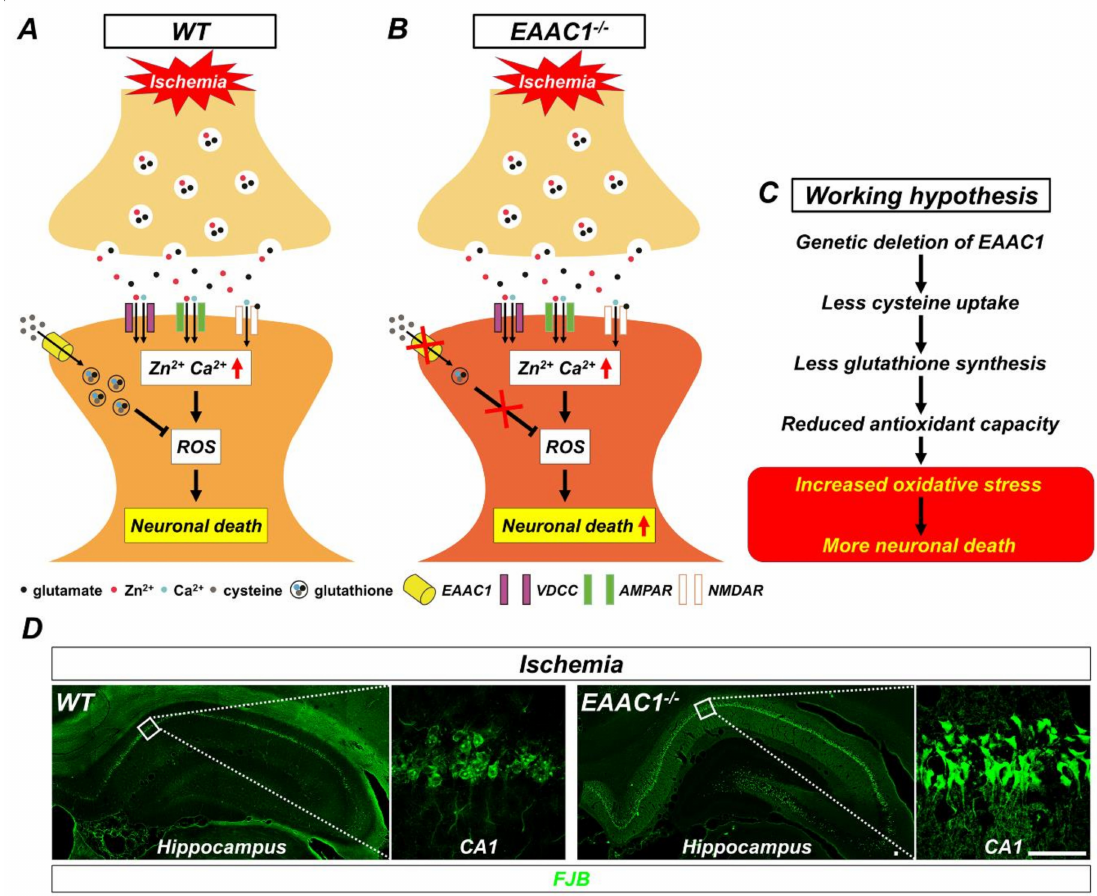
Figure 3. Proposed mechanism by which genetic deletion of EAAC1 increases ischemia-induced neuronal death. This illustration indicates several chain reactions that are thought to occur after the impairment of cysteine uptake into neurons as a result of EAAC1 gene deletion. ( A ) Glutamate and zinc are stored in presynaptic vesicles and released into synaptic clefts after ischemia. Excessive zinc can translocate into postsynaptic neurons and give rise to the disruption of calcium homeostasis, oxidative stress, and neuronal death. ( B ) Cysteine transport by EAAC1 is important for the synthesis of neuronal GSH. Reduced cysteine uptake due to EAAC1 gene deletion can lead to decreased GSH synthesis. ( C ) This can result in increased oxidative stress, which subsequently has a negative impact on the survival of neurons after ischemia. ( D ) Representative images showing Fluoro-Jade B (FJB)-positive cells, which indicate degenerating neurons, in the hippocampus of WT and EAAC1 − / − mice (3–5 months old; weight 25–35 g) at 3 days after ischemia (Insets show magnifications of white boxed areas). Scale bar = 50 µ